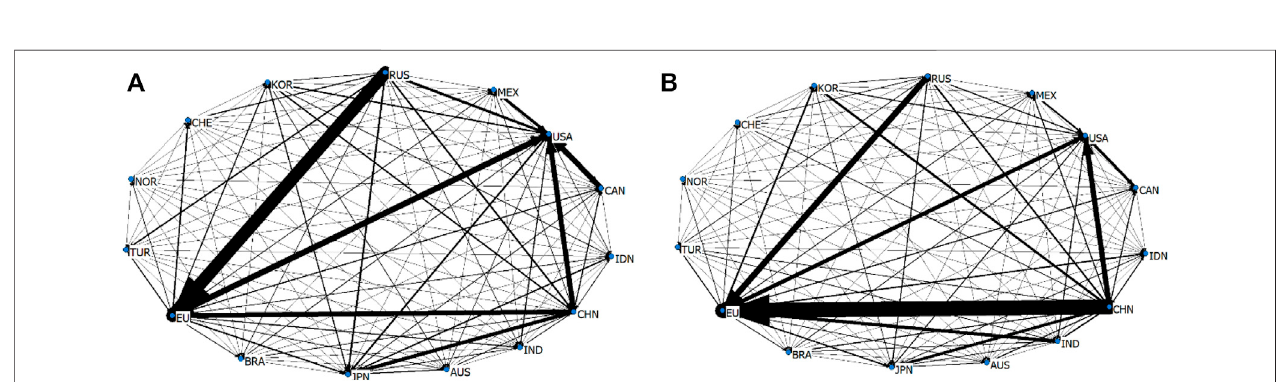
FIGURE 3 | Comparison of weighted networks of global trade embodied carbon in 2000 and 2014. (A) Network in 2000. (B) Network in 2014.